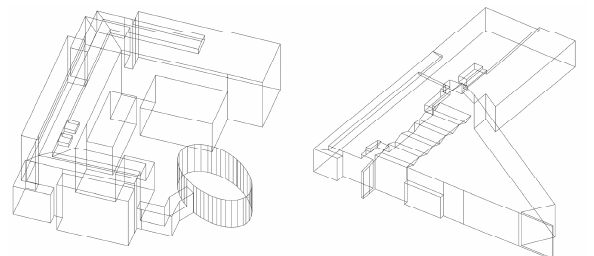
Figure 7. CityGML visualized in AutoCAD Civil 3D 2021.